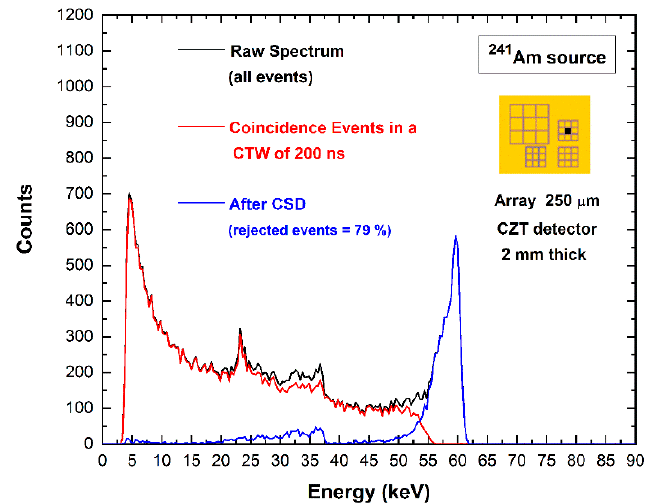
Figure 3. Charge-sharing measurements for the central pixel of the 250 μ m array. The blue line represents the uncollimated 241 Am spectrum after charge-sharing discrimination (CSD). The raw spectrum (black line) of all events and the spectrum of the coincidence events with all eight neighboring pixels (red line) are also shown. The yellow inset shows the layout of the anode of the detector.